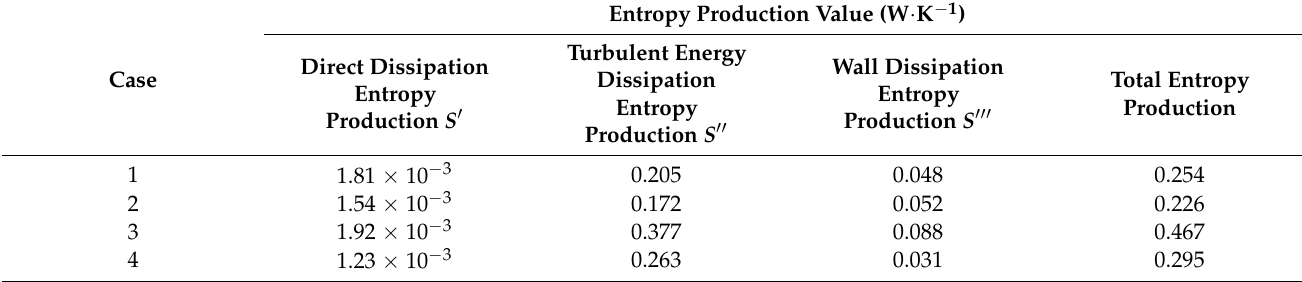
Table 1. Dissipation entropy production of each case.